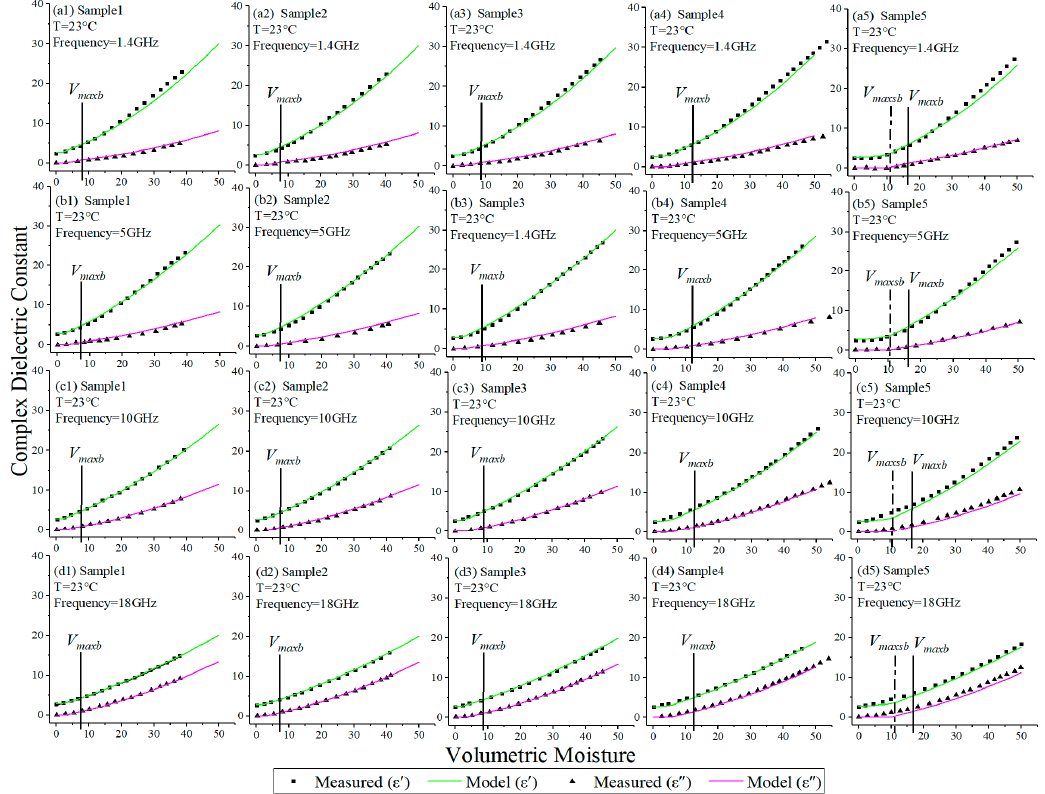
Figure 3. Comparison between results of the soil mixing complex dielectric model (Equation (15)) and measured data for real part and imaginary part; the black vertical line represents the maximum bound water content ( V maxb ); the black vertical dotted line represents the maximum strongly bound water content ( V maxsb ). ( a1 )–( a5 ) represents five types of soil in Table 1 at 1.4 GHz, respectively; ( b1 – b5 ) represents five types of soil in Table 1 at 5 GHz, respectively; ( c1 – c5 ) represents five types of soil